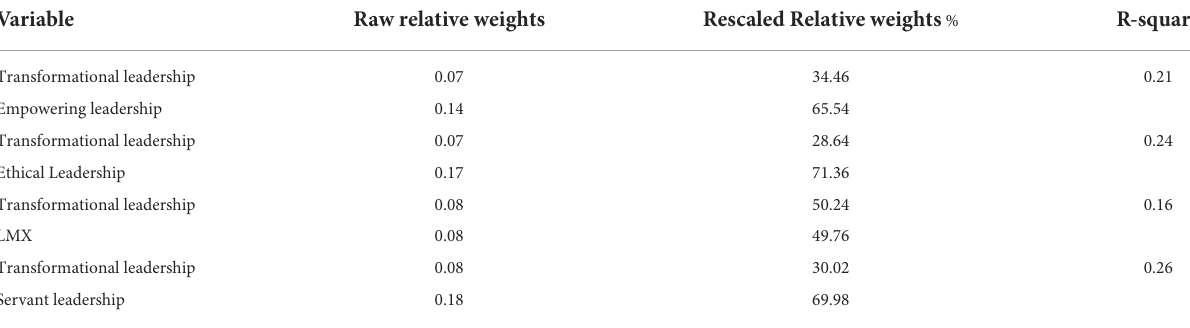
TABLE 5 Relative weights